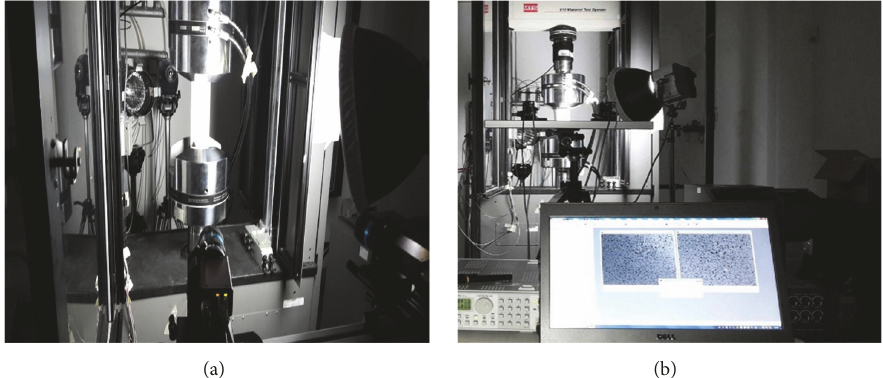
Figure 8: IRF and DIC test setup; (a) IRT and DIC cameras on the opposite side of the tested specimen; (b) complete test setup.